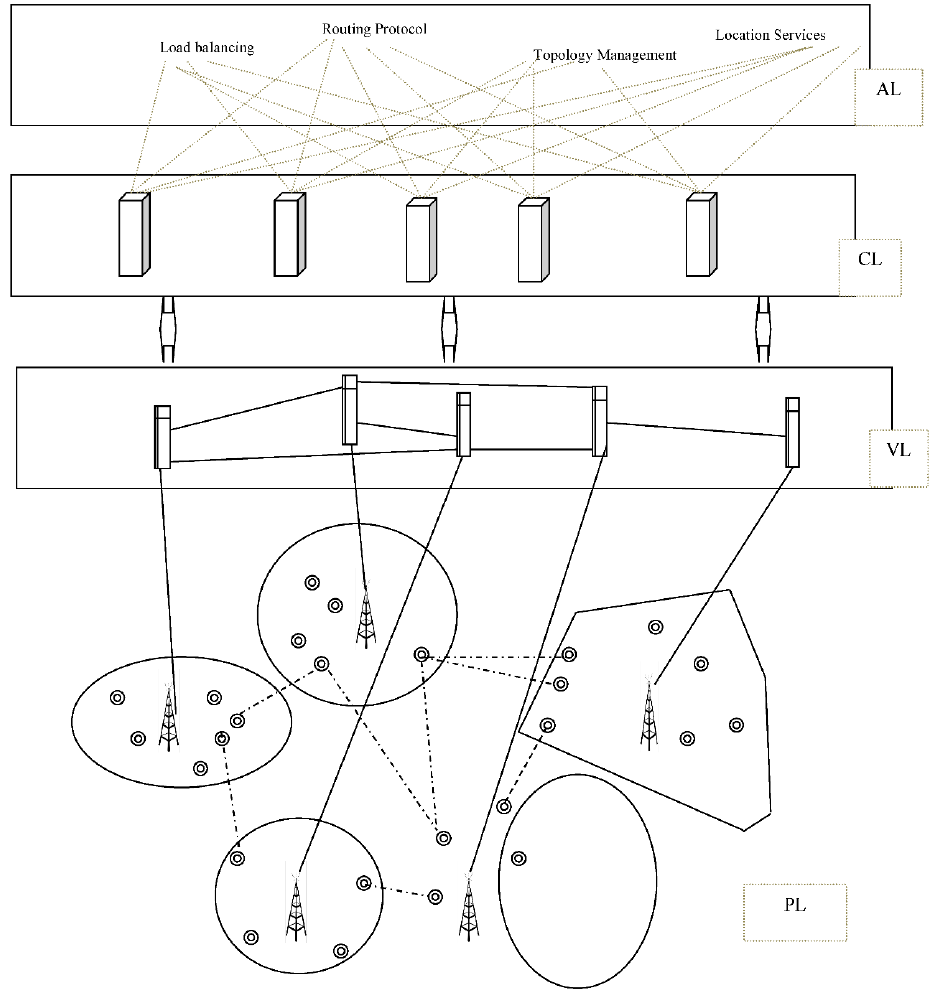
Figure 2. Network framework.